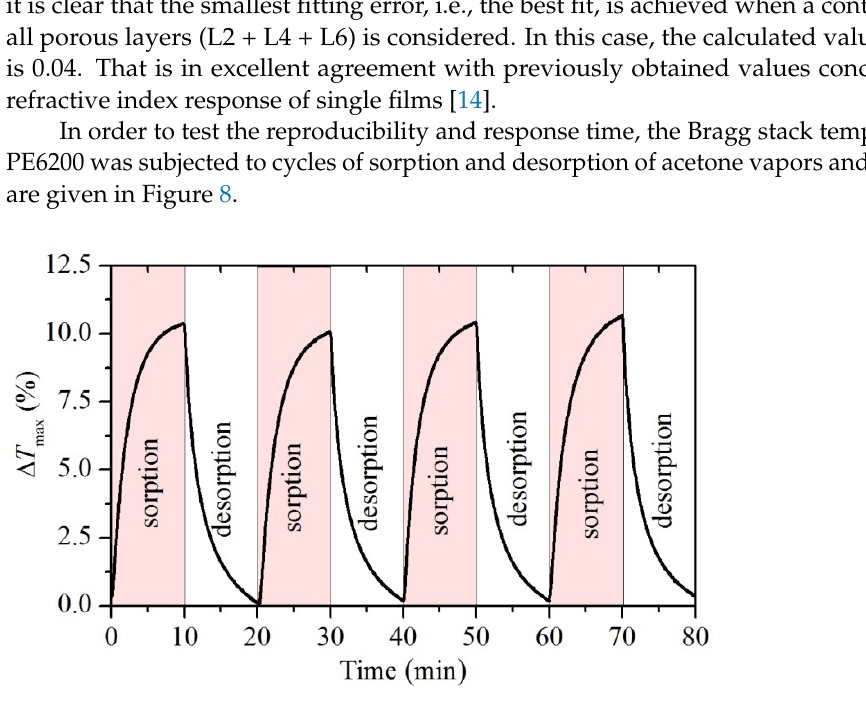
Figure 8. Sorption and desorption cycles of a 7-layer Bragg stack built from dense Nb 2 O 5 films and mesoporous one templated with Pluronic PE6200. The relative pressure p/p 0 = 0.15 (p 0 pressure of saturated vapors at 0 °C).